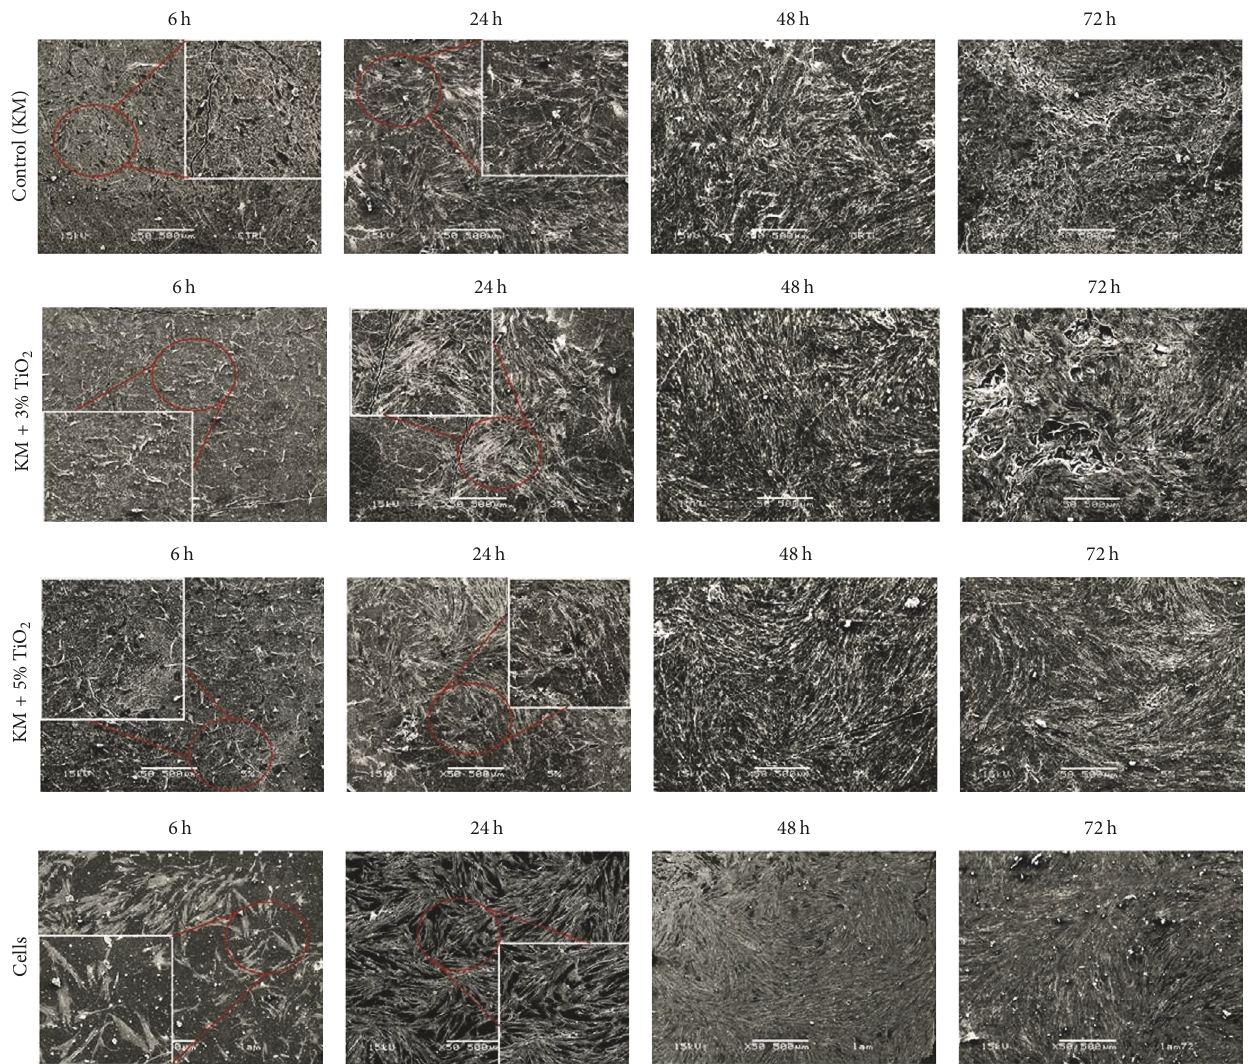
Figure 3: Scanning electron microscopic images of human gingival fibroblast cells adhered to different substrates at 6, 24, 48, and 72 h: control (KM); KM + 3% TiO 2 ; KM + 5% TiO 2 and culture dish (cells). Normal cell morphology was observed for all groups: numerous cells, near confluence, remained adhering to the glass substrate and exhibited an elongated morphology with several thin cytoplasmic prolongations originating from their membrane and formation of layer of cells at 48 and 72 h (SEM original magnification 50x). Table 3: Mean values ( 𝜇 g/well) and standard deviation (SD) for extracellular matrix (ECM) collagenous and noncollagenous content in cell cultures for days 7 and 14.